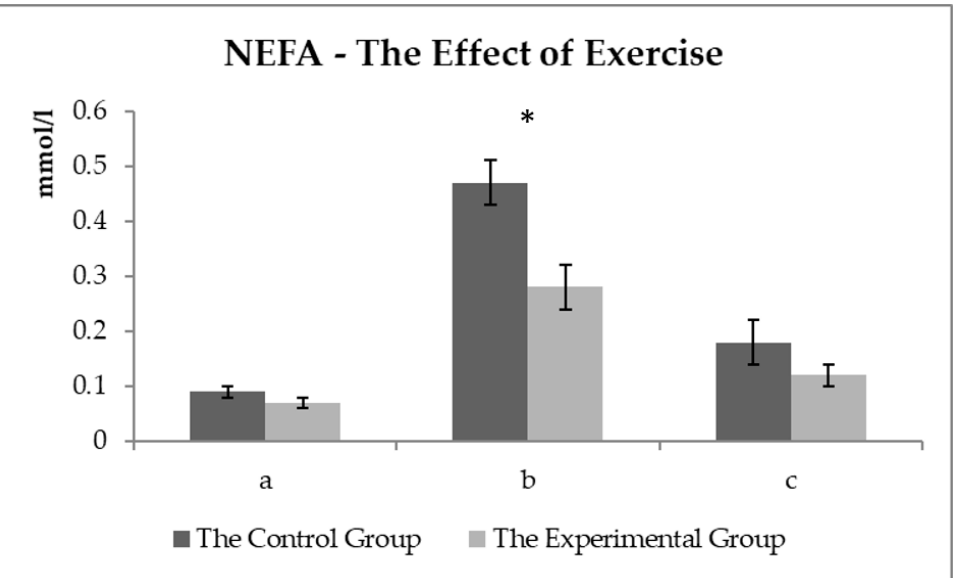
Figure 5. The NEFA values (mmol/L) in the control and experimental groups: ( a ) the values before the start of the training—sample two; ( b ) the values about 15 min after the end of the training—sample three; ( c ) the values about 60 min after the end of the training—sample four. * symbol indicates a significant difference between the control and experimental groups at the level of p < 0.05.